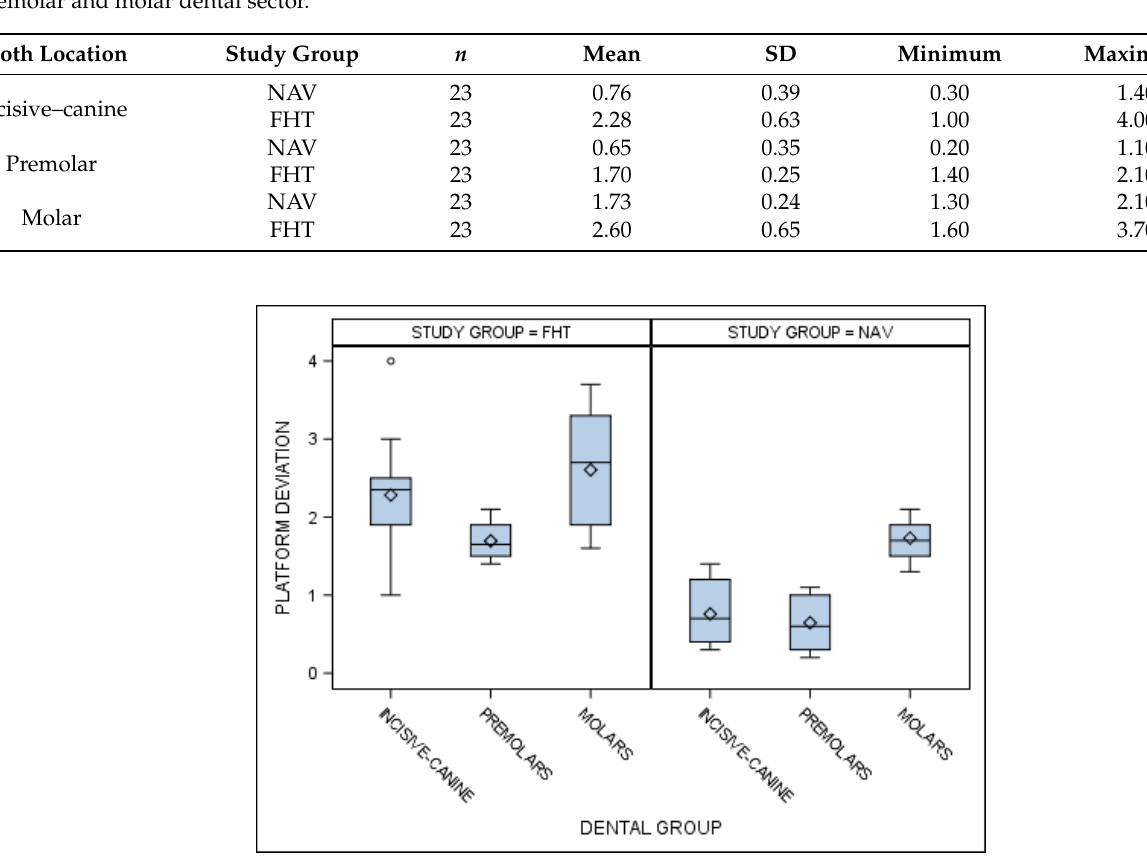
Figure 5. Box plot of the coronal entry-point deviations of the orthodontic micro-screws placed using the computer-aided static navigation technique and conventional freehand technique in the incisive – canine, premolar and molar dental sectors.